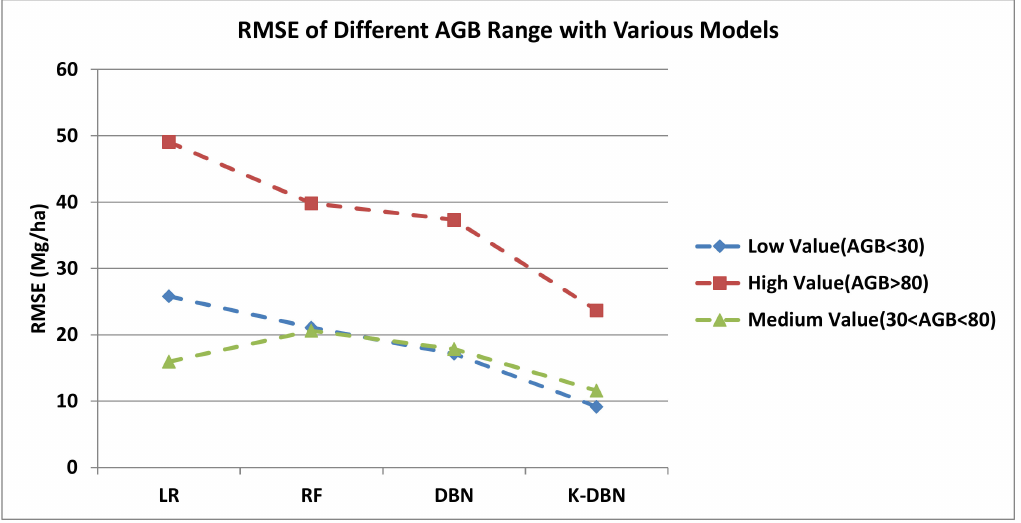
Figure 13. RMSE of different AGB range with various